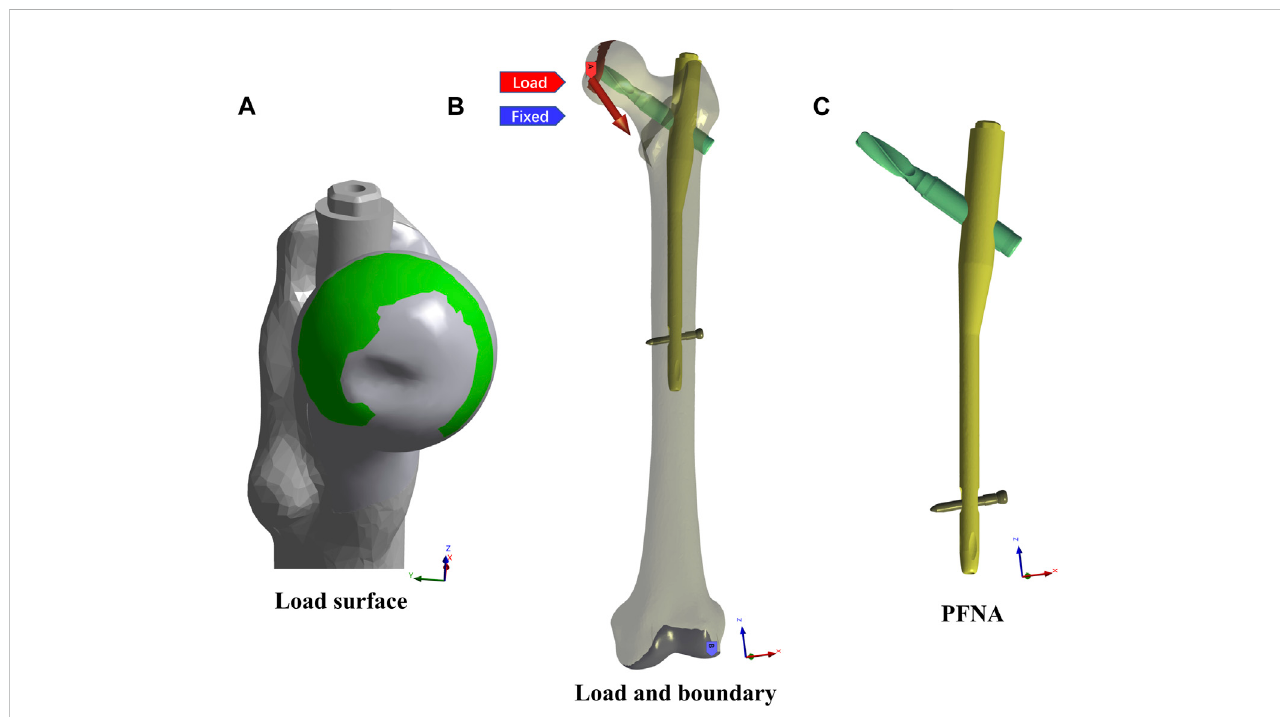
FIGURE 2 Theload,boundaryconditions,andthePFNAmodelwereexhibited. (A) showedtheloadsurface,onwhichthestaticwalkingandclimbinghiploadswere exerted. (B) showed the static load site and direction and the FE model fi xed site. (C) showed the PFNA model.